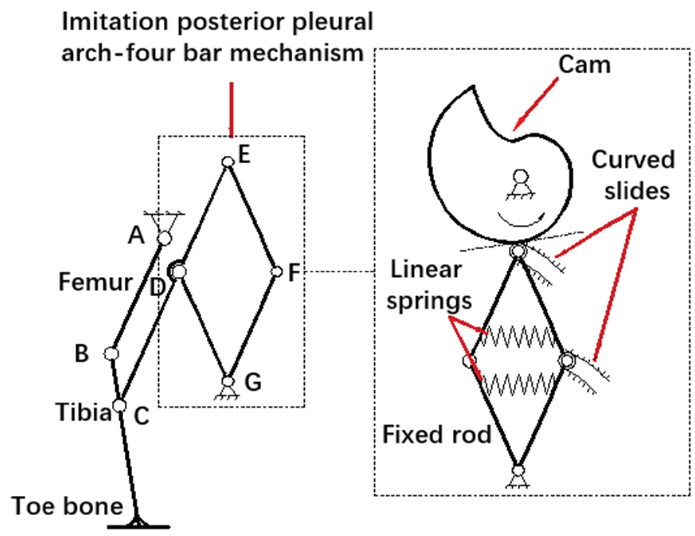
Figure 2. Structural diagram of the single six ‐ link jump mechanism model.